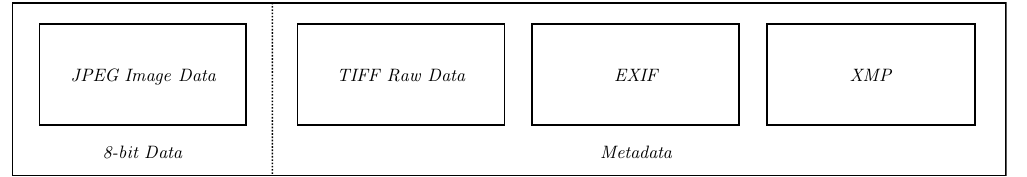
Figure 5. Schematic of file structure of FLIR image